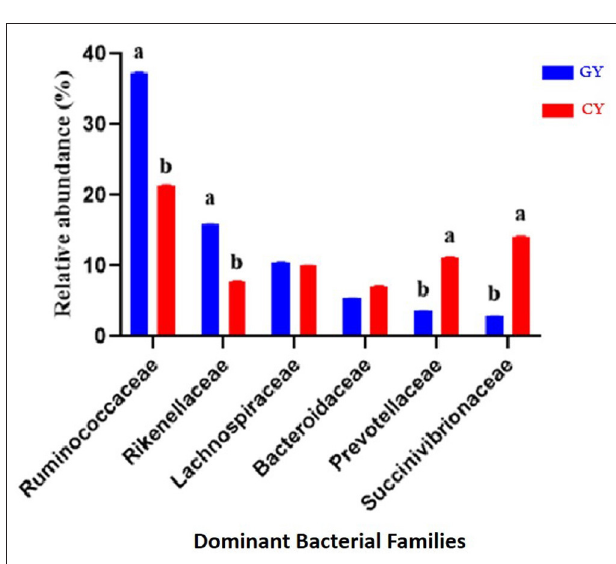
FIGURE 4 | Major bacterial phyla found in yaks fed on natural grazing pasture (GY) and feedlots (FY). Bars with different superscripts indicate that mean values are significantly different from each other ( p < 0.001).